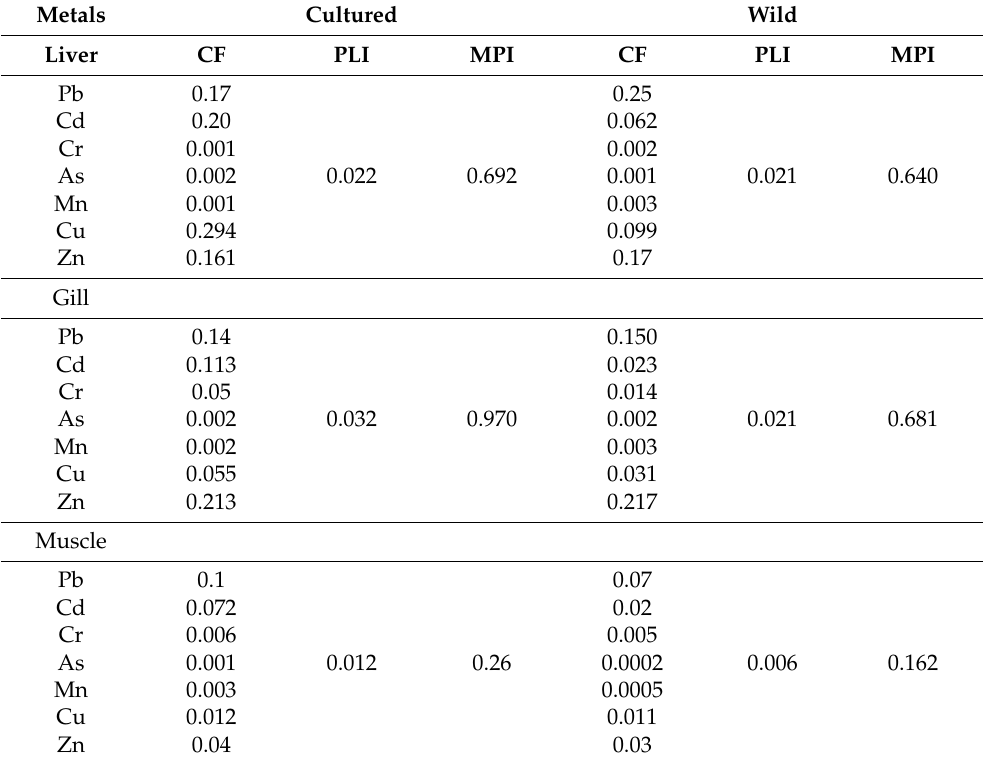
Table 4. Values of the contamination factor (CF), pollution load index (PLI), and metal pollution index (MPI) of cultured and wild Barramundi